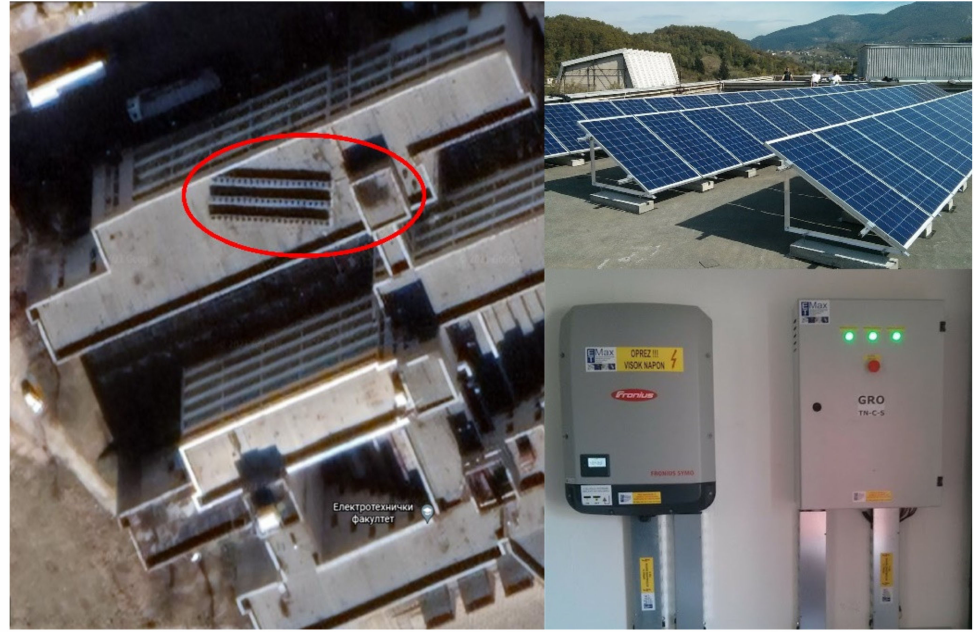
Figure 5. Location and disposition of the grid-connected PV